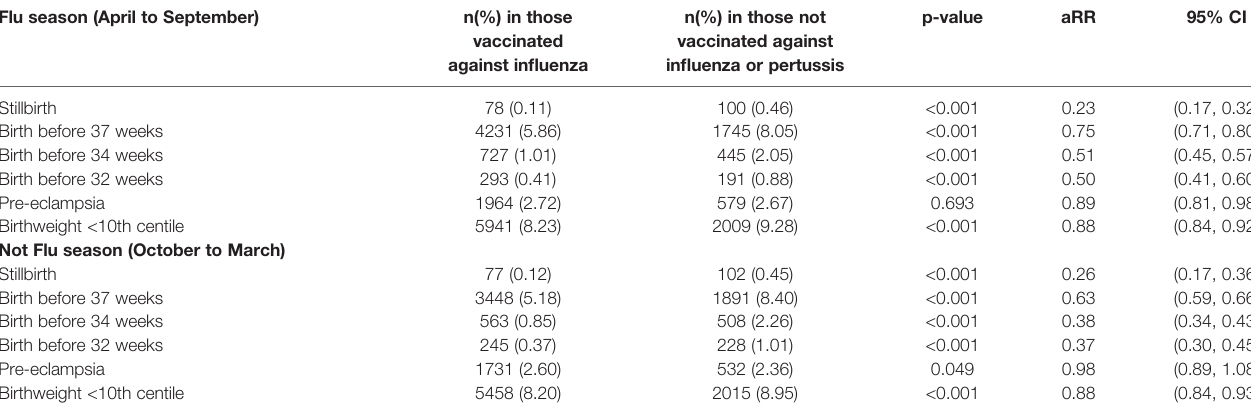
TABLE 4 | Effect of in fl uenza vaccination on obstetric outcomes by birth during versus outside of in fl uenza season. Flu season (April to September)